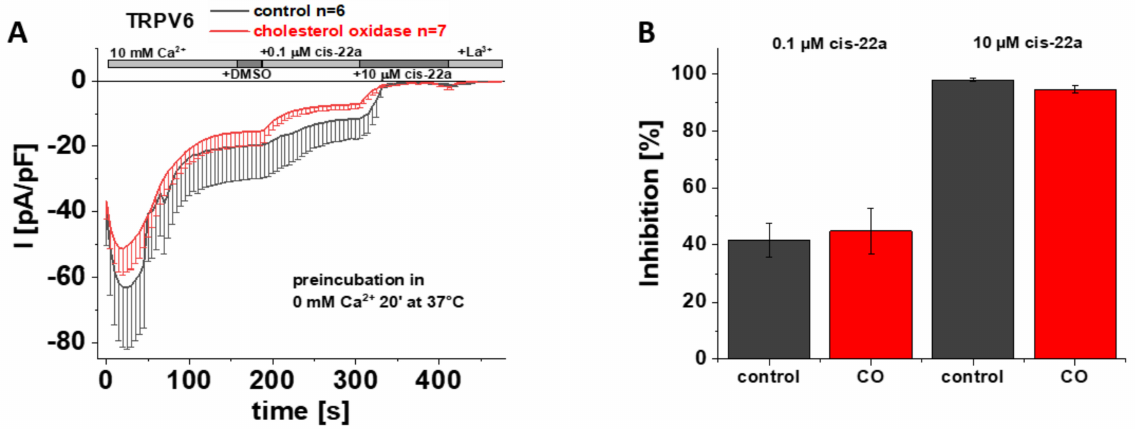
Figure 6. Preincubation with cholesterol oxidase has no effect on TRPV6 WT inhibition by cis-22a. ( A ) Averaged time course of whole-cell currents (mean ± SEM) recorded from HEK293 cells